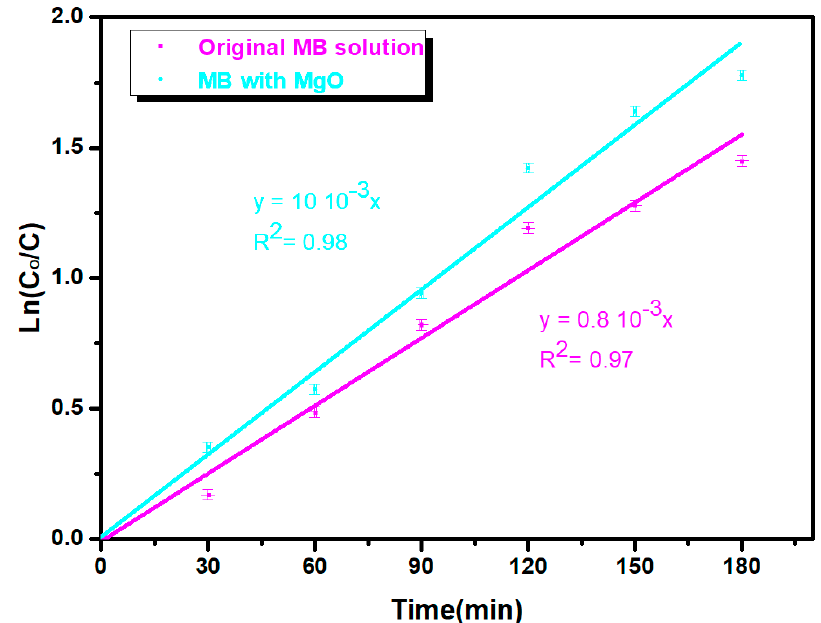
Figure 11. Variation in Ln (C 0 /C) of original MB solution (pink) and with MgO (blue) thin films under sunlight irradiation for different times (30, 60, 90, 120, 150 and 180 min). Error bar is 0.02.